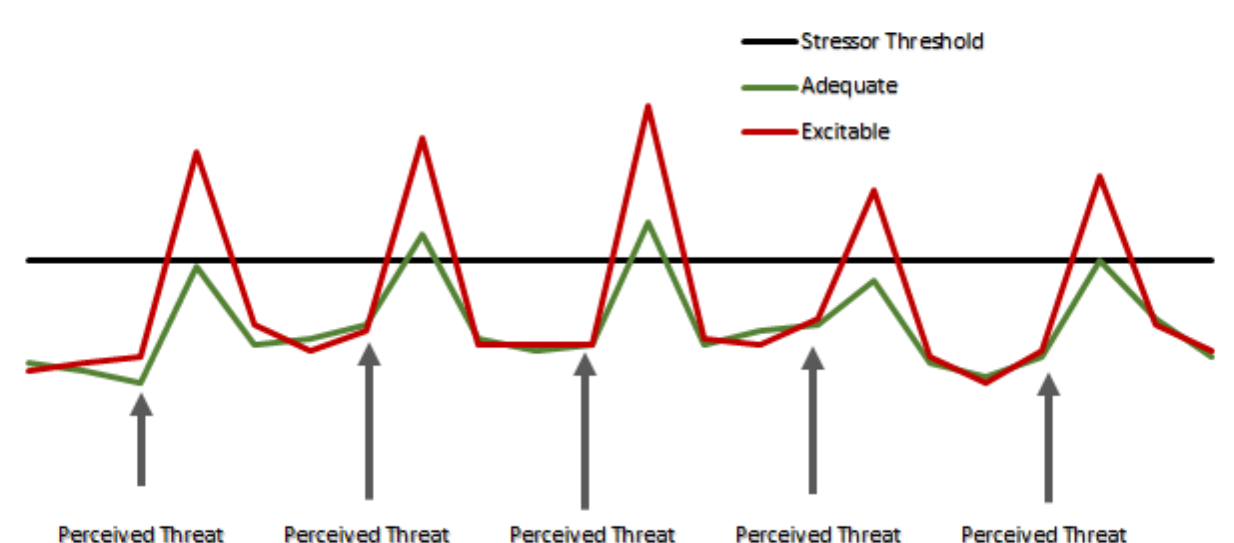
Figure 1. Proposed scheme of circulating concentrations of cortisol (not in scale) in excitable vs. adequate cattle in response to perceived threats (i.e., human handling for blood collection). It is speculated herein that basal levels of cortisol are similar between two temperament types, according to assessment of chronic stress via hair cortisol analysis [31]. Sampling events are perceived as threats by beef cattle, eliciting a stress neuroendocrine response. Peaks represent the blood collection moments, in which the differences between temperament types are noticed and described in literature [4,27– 29,35,36].